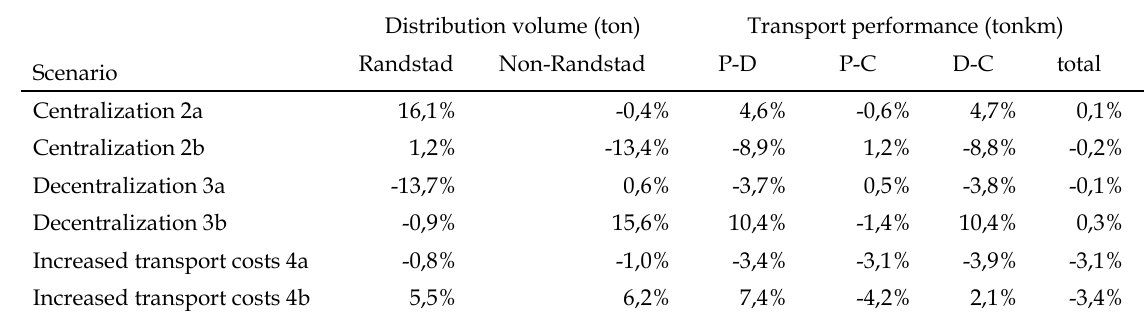
Changes in distribution throughput and